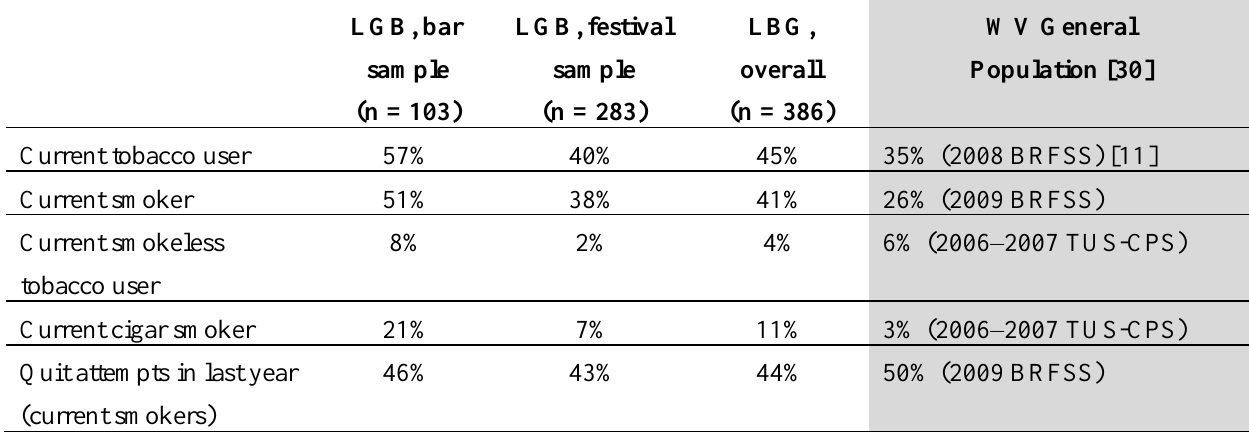
Table 3. LGB tobacco use and quit attempts by sexual orientation among WV